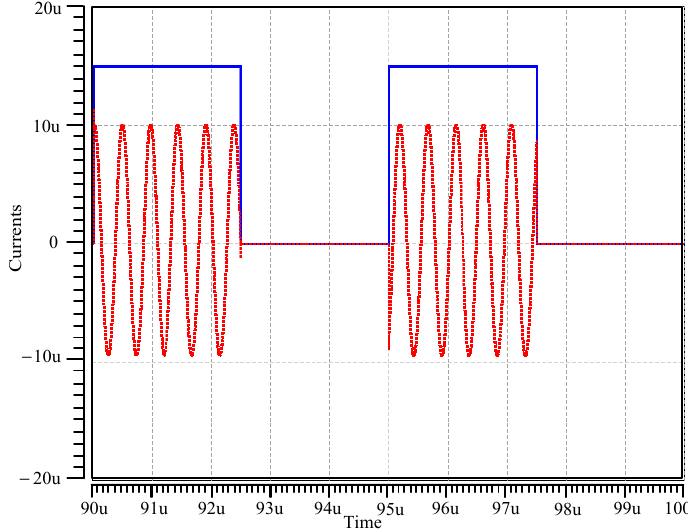
Figure 10. Simulated result of operation as an AM signal generator when I B 2 is the applied triangular signal.